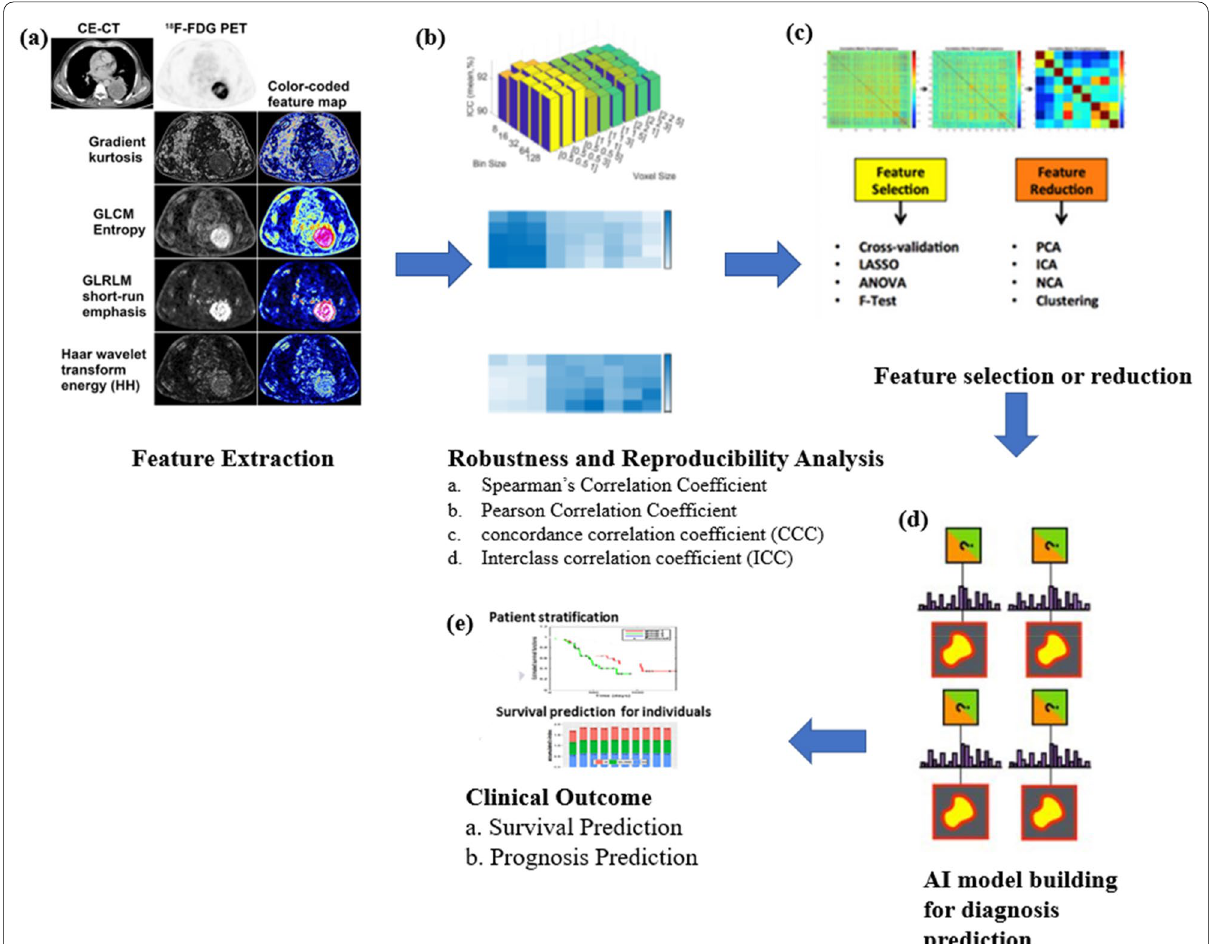
Fig. 1 The overview of optimisation of radiomics feature for its translation in clinical